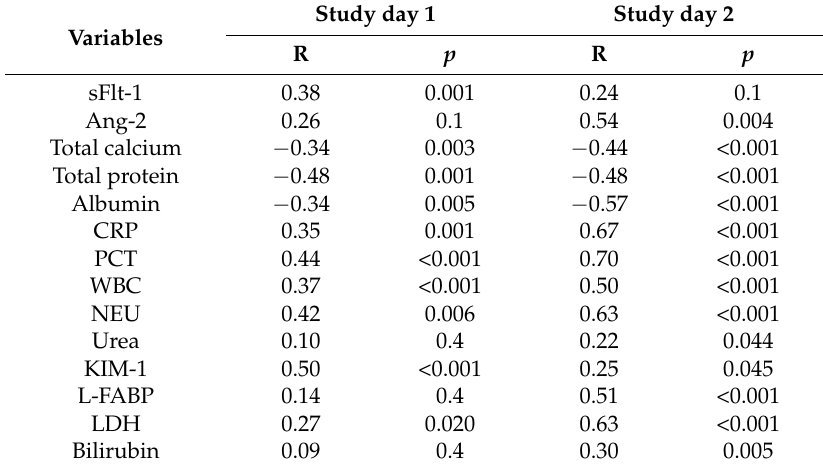
Table 3. Correlations between IL-6 and selected laboratory markers in patients with AP during first 48 h of disease.